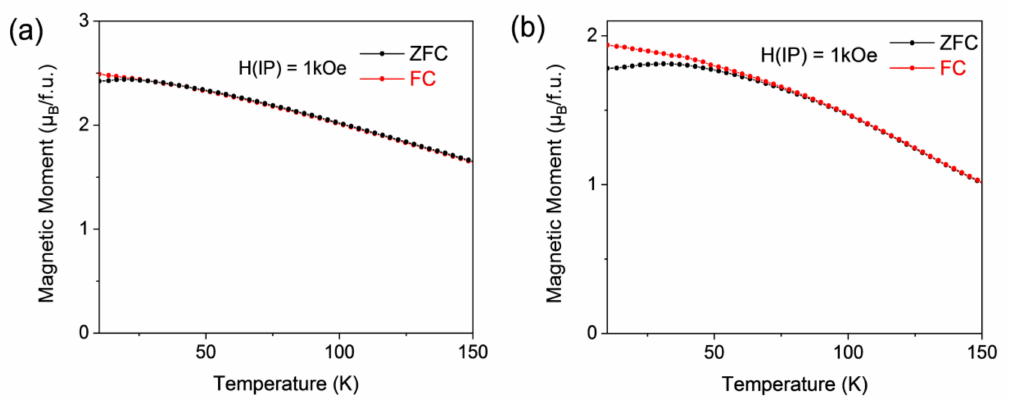
Figure 7. Zero-field-cooled (ZFC) and field-cooled (FC) magnetization curves measured at fields of 1 kOe for LNMO / STO epitaxial thin film samples grown by: ( a ) conventional thermal annealing (CTA) with 2 ◦ C / min heating and cooling ramps, dwell time 30 min at 875 ◦ C under oxygen flow, 0.4 L / min; ( b ) RTA conditions, 20 ◦ C / s heating ramp, dwell time 20 min at 900 ◦